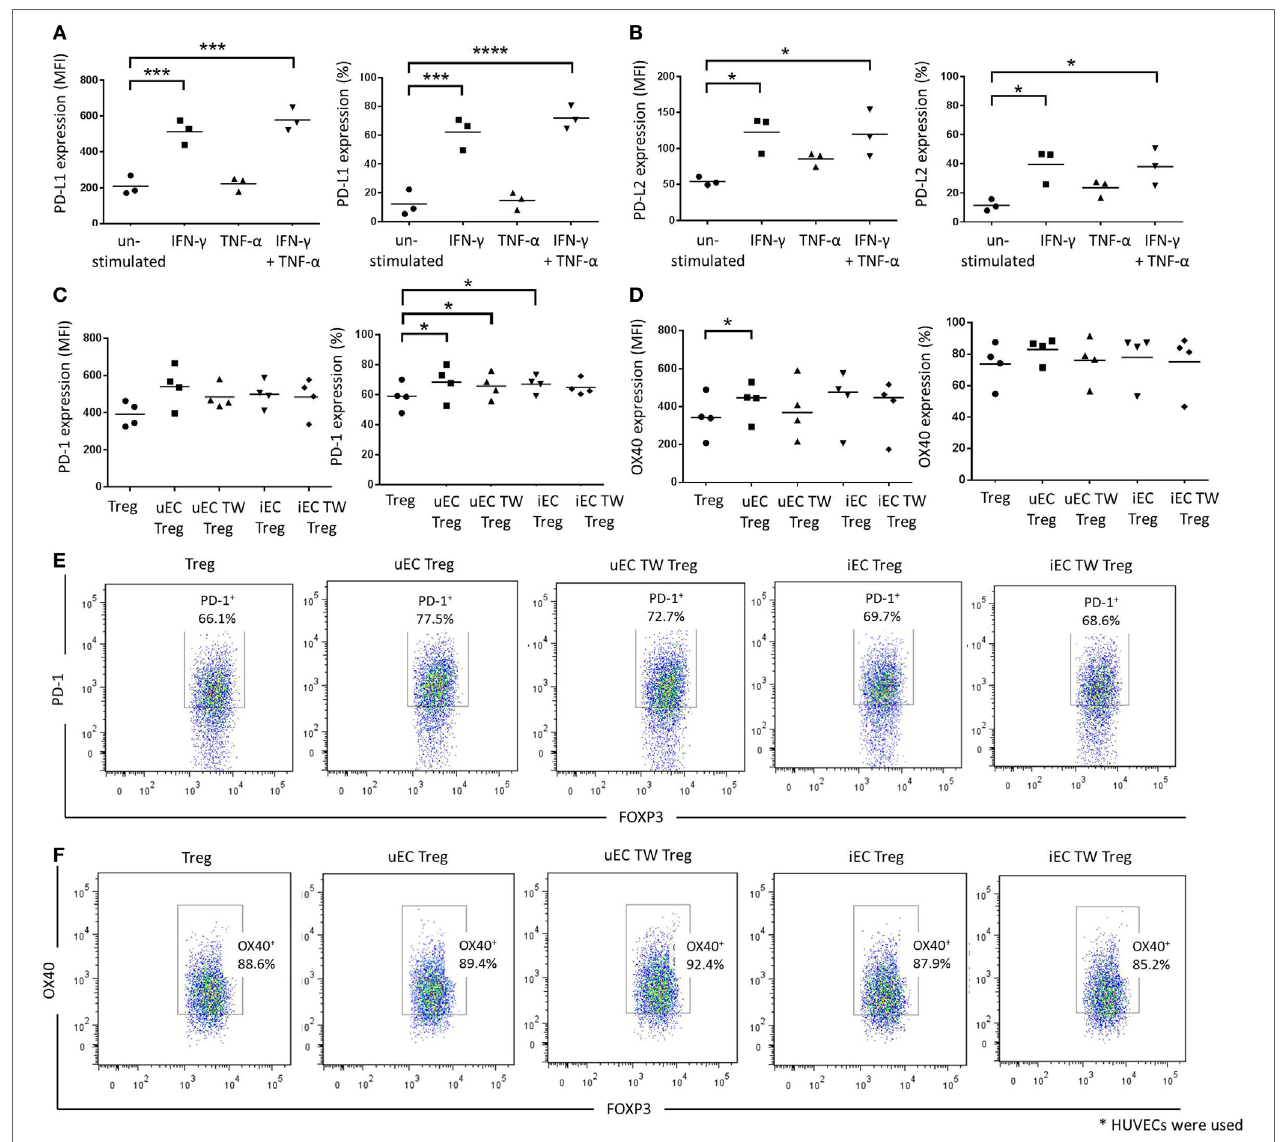
FigUre 5 | Involvement of PD-1/programmed death ligand (PD-L)1/2 in the contact-dependent interactions between HUVEC and Tregs. Human umbilical vein ECs (HUVECs) were stimulated with 10 U/mL IFN- γ , 1 ng/mL tumor necrosis factor (TNF)- α , or combination of both cytokines for 24 h. Cells were then stained and analyzed for (a) PD-L1 or (B) PD-L2 expression using flow cytometry. Data are expressed as mean fluorescence index (MFI) and percentage of positive cells, with means shown. One-way analysis of variance (ANOVA) with Dunnett’s test was conducted; **** P < 0.0001, *** P < 0.001, * P < 0.05; n = 3. Modulation of Treg phenotype after HUVEC interactions were also investigated whereby Tregs were plated in direct contact with unstimulated (uEC Treg) or IFN- γ -stimulated (iEC Treg) HUVECs, or in the upper chambers of Transwells with unstimulated (uEC TW Treg) or IFN- γ -stimulated (iEC TW Treg) HUVECs. Tregs were then recovered and plated in a Treg suppression assay and analyzed for (c) PD-1 and (D) OX40 expression after 72 h using flow cytometry. One-way ANOVA with Dunnett’s test was conducted; * P < 0.05; n = 3. Plots of a representative experiment are shown in Figures (e,F)